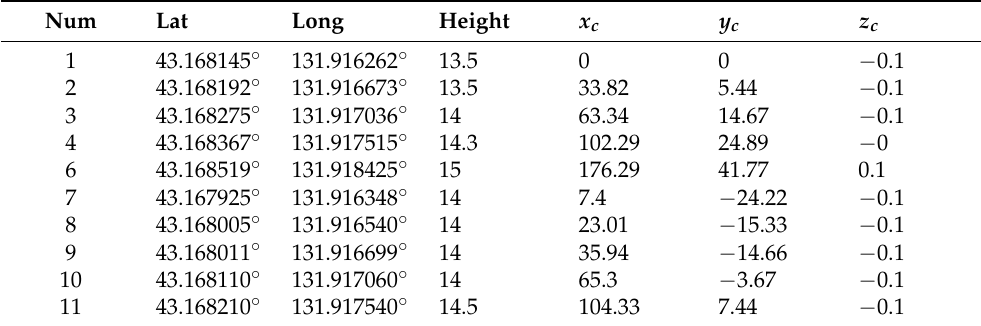
Table 5. The points used to approximate road plane Π (global and F c coordinates, F c and altitudes given in meters).